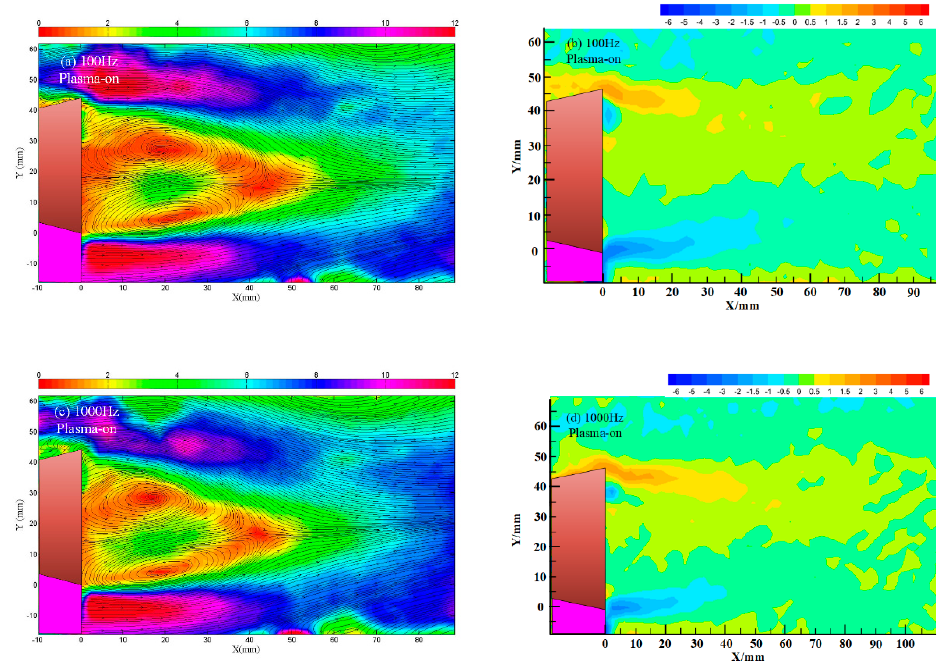
Figure 21. Time − averaged flow structures ( left ) and vorticity contours ( right ) of the flame − holder wake at different discharge frequencies, ( a , b ) 100 Hz discharge frequency, ( c , d ) 1000 Hz discharge frequency.